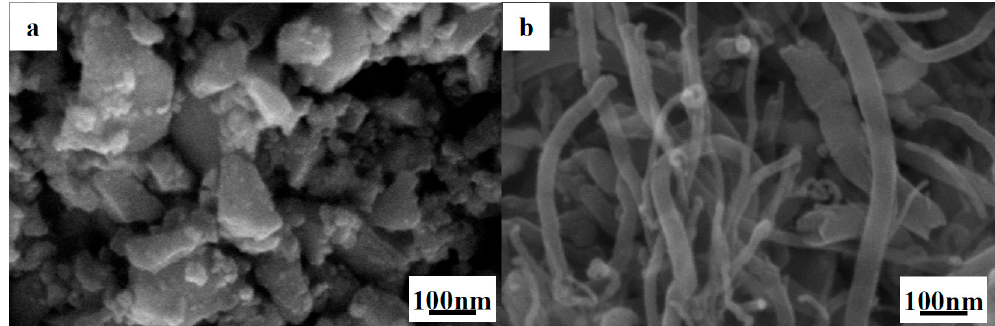
Figure 1. Micrographs of the as-received powders by secondary electron scanning electron